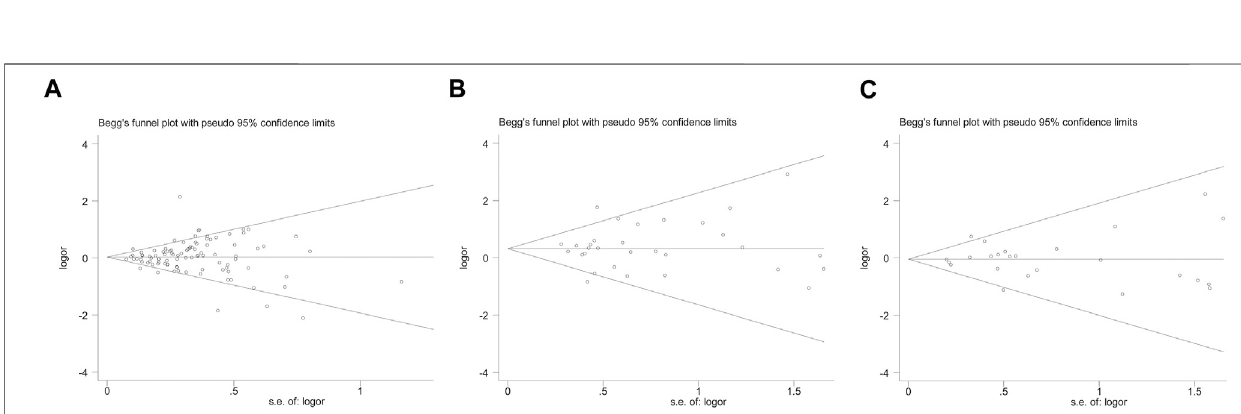
Frontiers in Genetics |